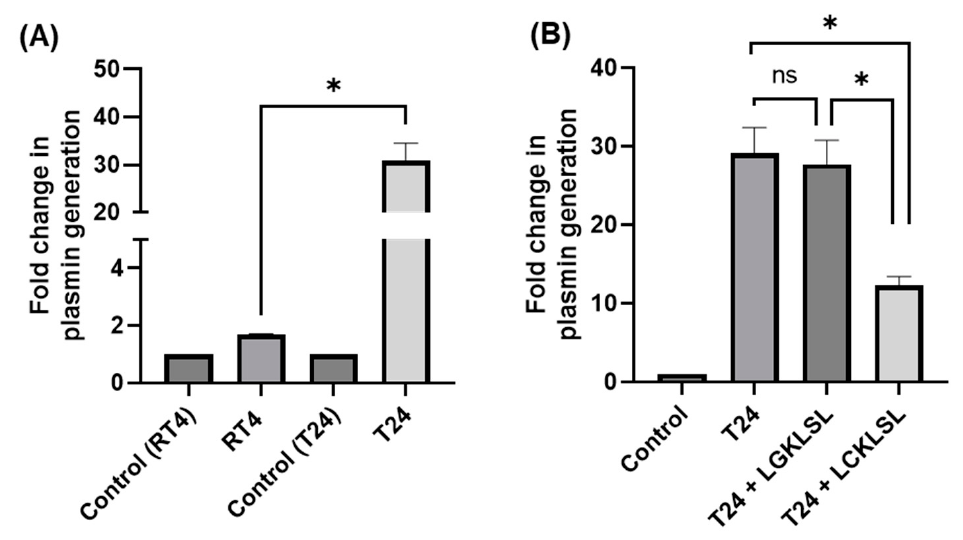
Figure 4. AnxA2 ‐ mediated plasmin generation. ( A ) Chromogenic plasmin generation assay was performed in RT4 and T24 bladder cancer cell lines as described in the materials and methods. To serve as a control, Glu ‐ plasminogen was omitted from the reaction mixture. The fold increase in plasmin generation was determined. ( B ) Chromogenic plasmin generation assay was performed in T24 in the presence of either AnxA2 inhibitory hexapeptide (LCKLSL; 1 mM) or control peptide (LGKLSL; 1 mM). The fold change in plasmin generation was obtained. The data are means ±SEM ns , non-significant; *, p < ( n = 3). ns , non ‐ significant; *, p < 0.05. ( n = 3).